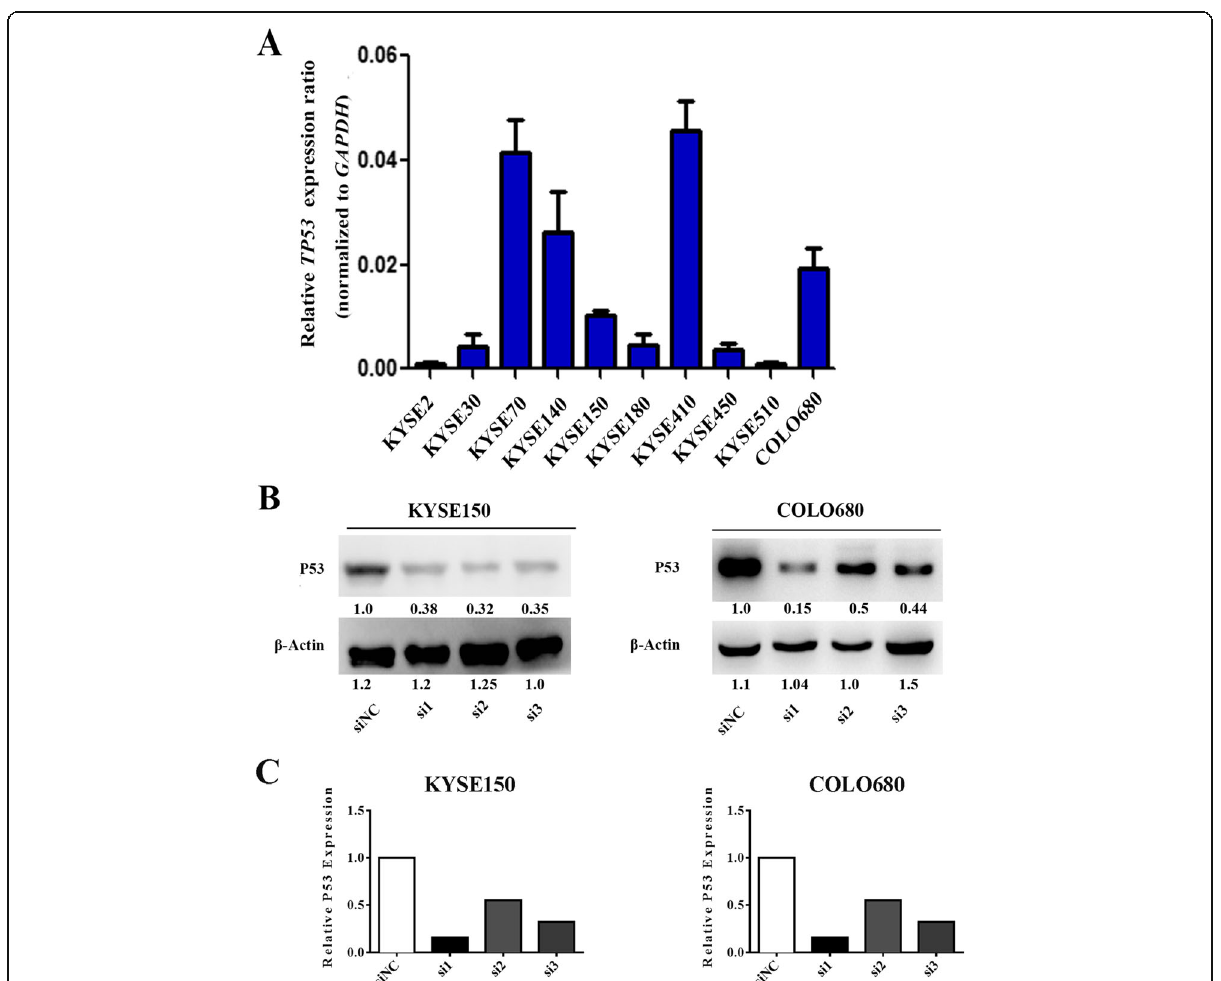
Fig. 1 TP53 expression levels in ESCC cell lines. a qRT-PCR analysis of the relative TP53 mRNA levels in nine ESCC cell lines. TP53 mRNA levels in KYSE150 and COLO680 were considerate high. b Western blot assay was applied to verify the expression of P53 in KYSE150 and COLO680 after siRNAs treatment, which express relatively higher levels of P53 and contain wild-type P53. c Gray scale scanning analysis was employed